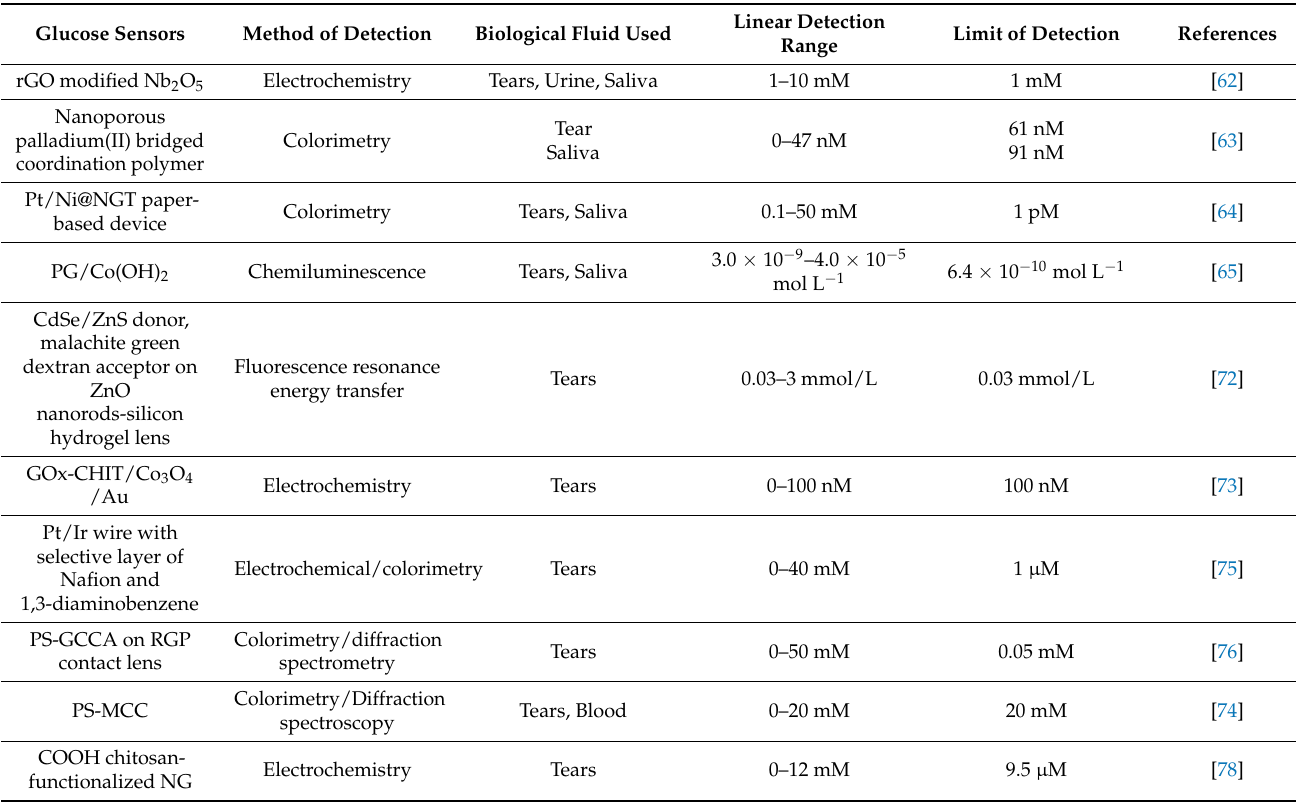
Table 2. The performance of various tear-based glucose